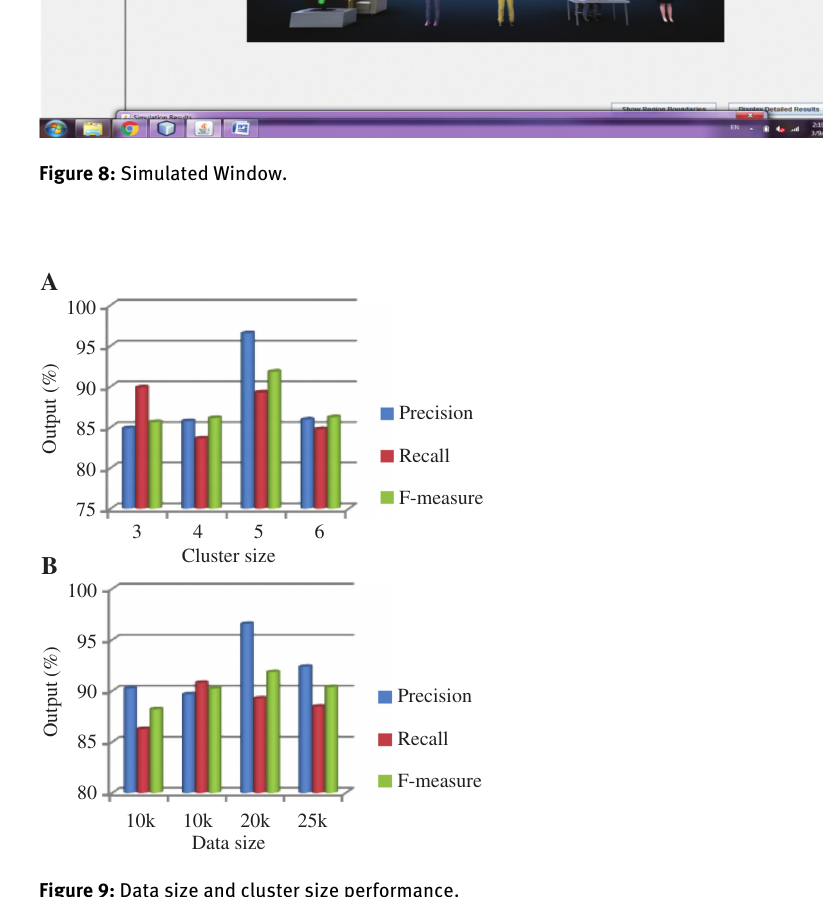
Figure 9: Data size and cluster size performance. Performance Analysis (A) by Varying Cluster Size and (B) by Varying Data